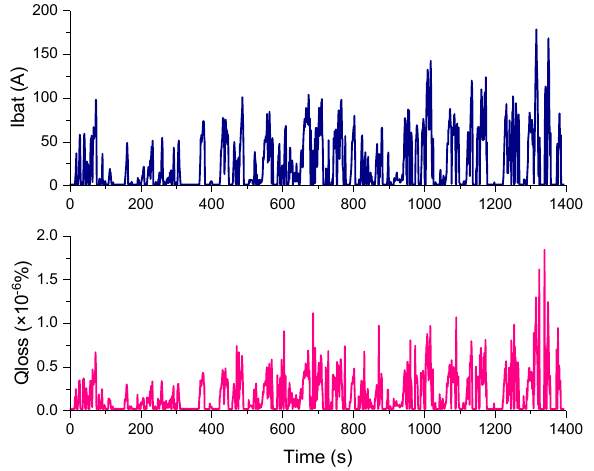
Figure 12. Battery current and battery degradation percentage at room temperature of 25 °C based on convex optimization.